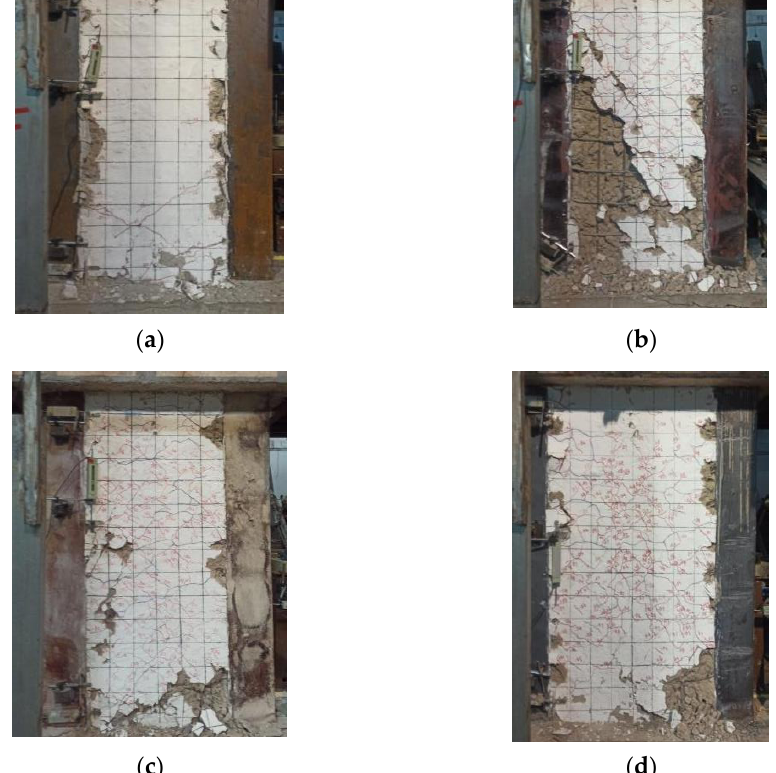
Figure 13. Failure patterns of specimens. ( a ) SW1; ( b ) SW2; ( c ) SW3; ( d ) SW4.